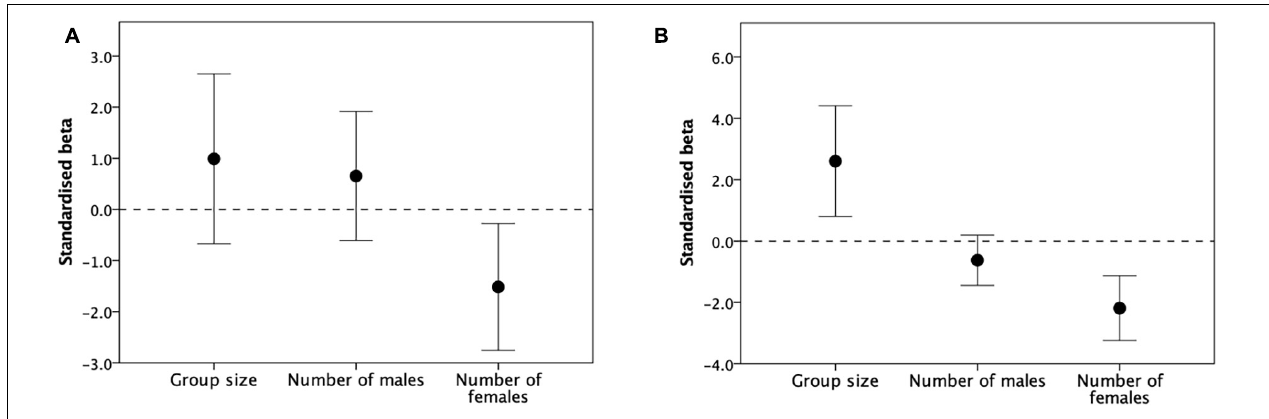
FIGURE 7 | Mean ( ± 95% CI) standardised slope coefficients for total group size, number of males and number of post-puberty females as predictors of (A) birth rate (from Figure 4 ) and (B) reproductive output (surviving immatures per female: from Figure 5 ) for individual primate